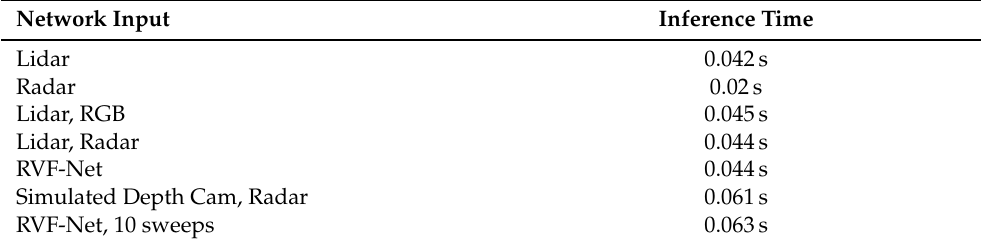
Table 4. Inference times of different sensor input configurations on the NVIDIA Titan Xp GPU.